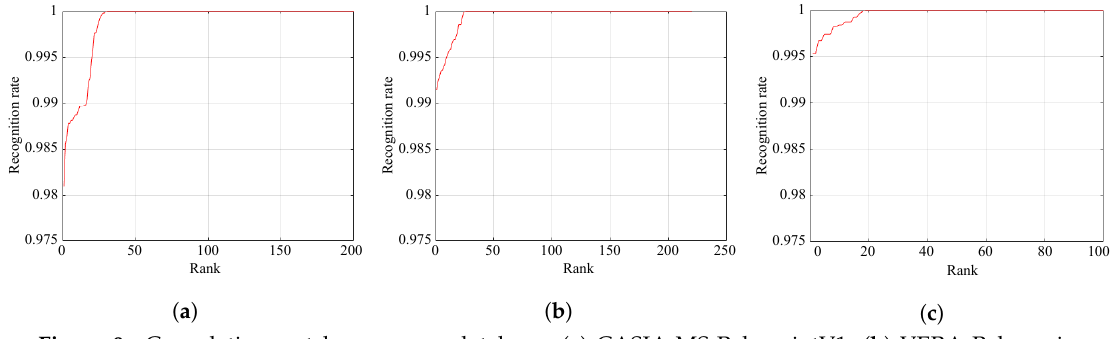
Figure 9. Cumulative match curves on database: ( a ) CASIA-MS-PalmprintV1; ( b ) VERA Palm vein; and ( c ) PUT Vein. Table 6. Results of the proposed method on the databases in identification